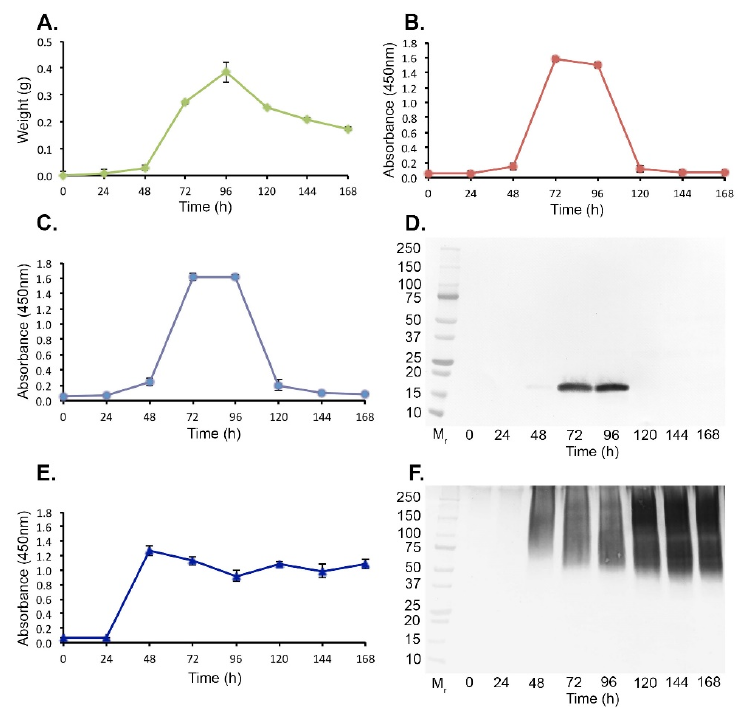
(Figure 2D) using representative samples at each time point, revealed a similar trend to ELISA tests, with production of a single 18 kDa ribotoxin first discernible at 48 h post- inoculation, stronger detection at both 72 h and 96 h post-inoculation, and absence of pro- duction thereafter. As a means of comparison with other extracellular Aspergillus antigens, we tested the same samples by PTA-ELISA (Figure 2E) and Western blot (Figure 2F) with mAb JF5, an Aspergillus- specific mAb that binds to galactofuranose-rich peptidoglycans. The dynamics of JF5 antigen production were markedly different to those of ribotoxin production, with antigen production peaking at 48 h post-inoculation and plateauing thereafter. This shows that while both antigens are secreted into the culture filtrate in the early phases of fungal growth, and both require germination of spores for antigen pro- duction, ribotoxin production is strictly limited to the hyphal growth phase, and does not accumulate post-sporulation, unlike secreted peptidoglycans.